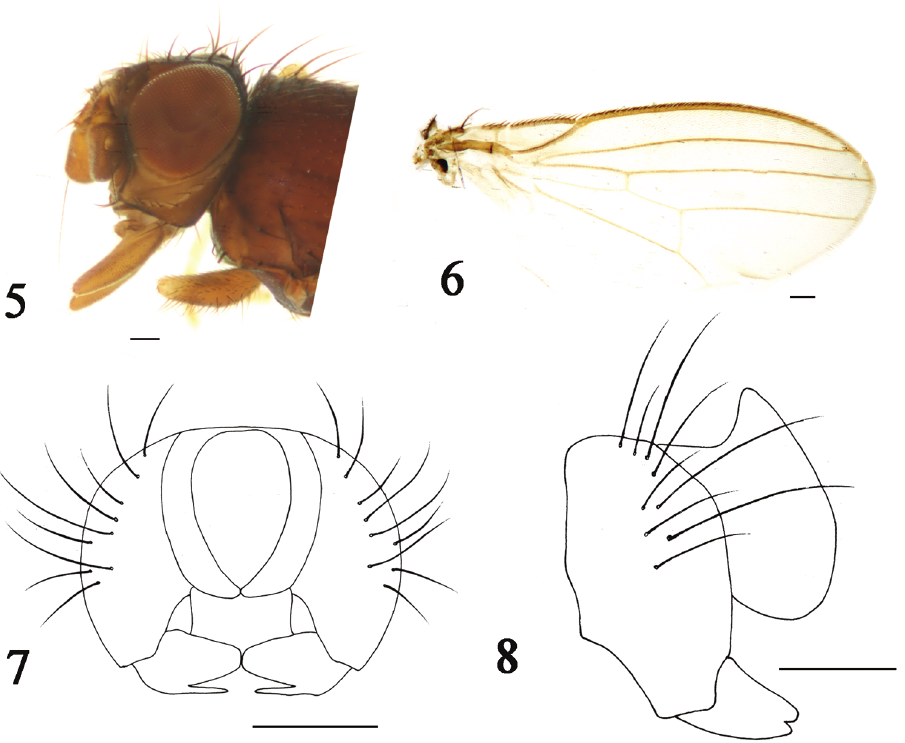
Figures 5–8. Phyllomyza luteigenis sp. n. (male). 5 Head, lateral view 6 wing 7 epandrium, cerci, and surstyli, posterior view 8 epandrium, cerci, and surstyli, lateral view. Scale bars: 0.1 mm.